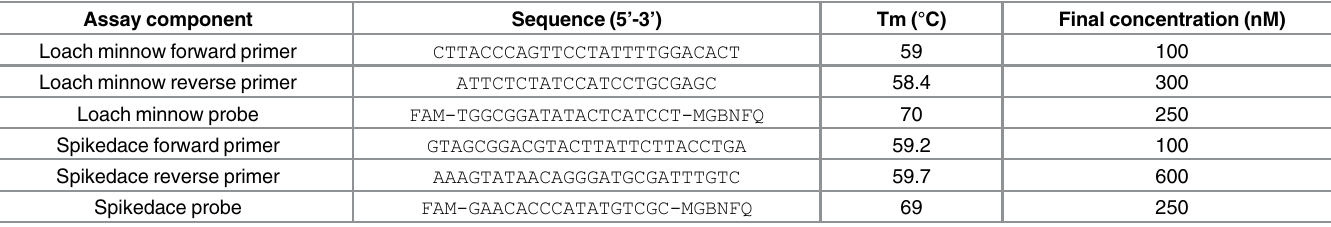
Table 2. Primers and probes to detect loach minnow and spikedace using qPCR. Assay